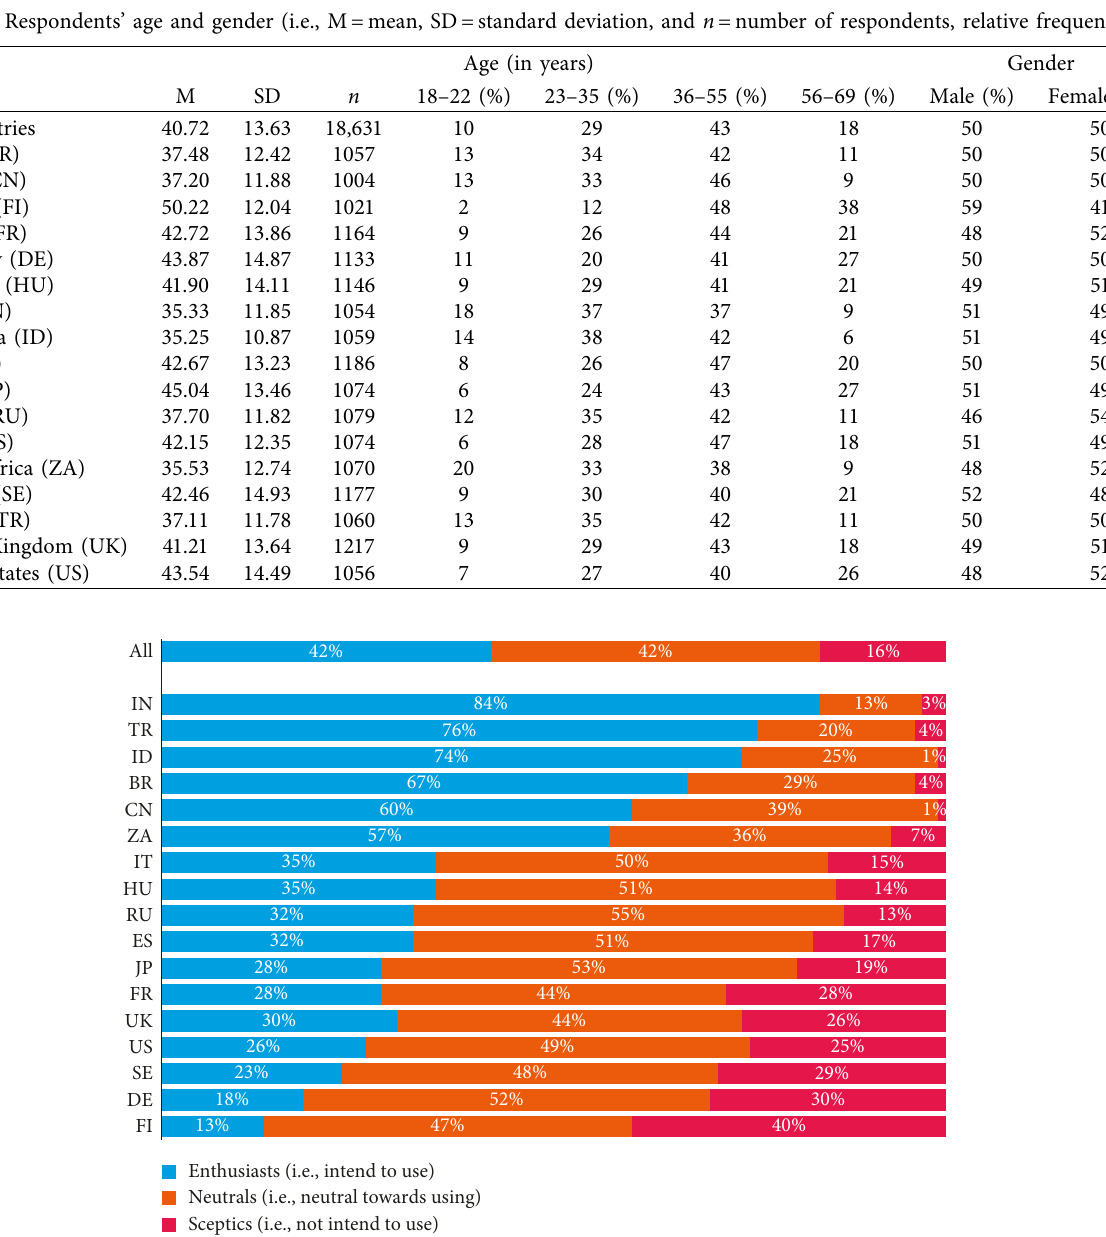
Figure 1: Percentage values of Enthusiasts, Neutrals, and Sceptics towards conditionally automated cars ( M � 3.38, SD � 1.09, and n �